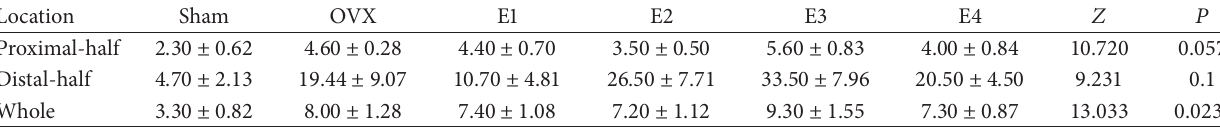
Table 4: Histological scores of ER 𝛼 according to location in all groups ( 𝛼 = 0.05 , two-tailed).